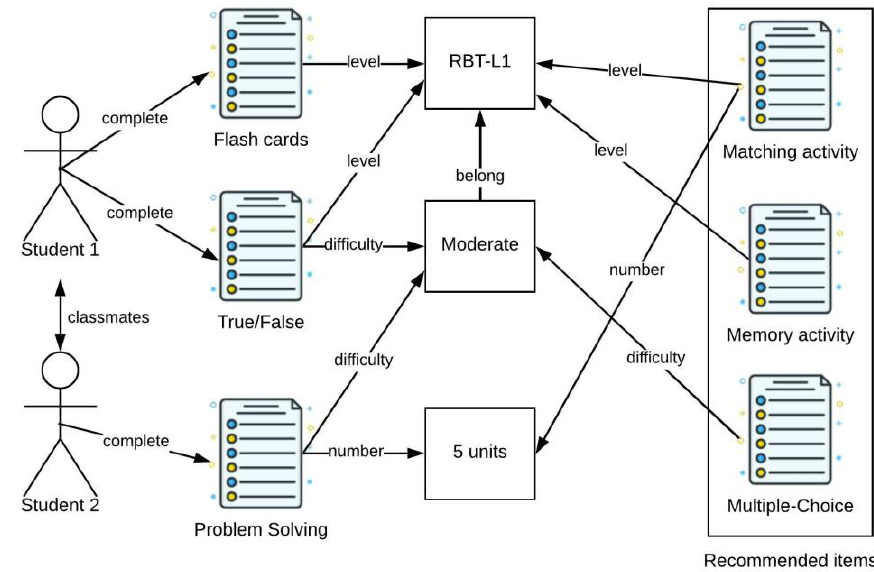
Figure 1. Example of operation.